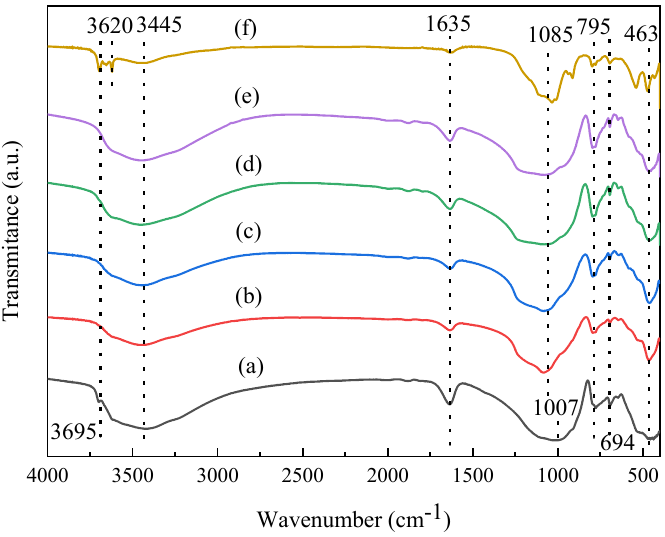
Figure 2. FT-IR spectra of Vrm (a) Vrm-HS15 (b) Vrm-HS35 (c) Vrm-HC35 (d) Vrm-HP35 (e) Vrm-3rd (f).